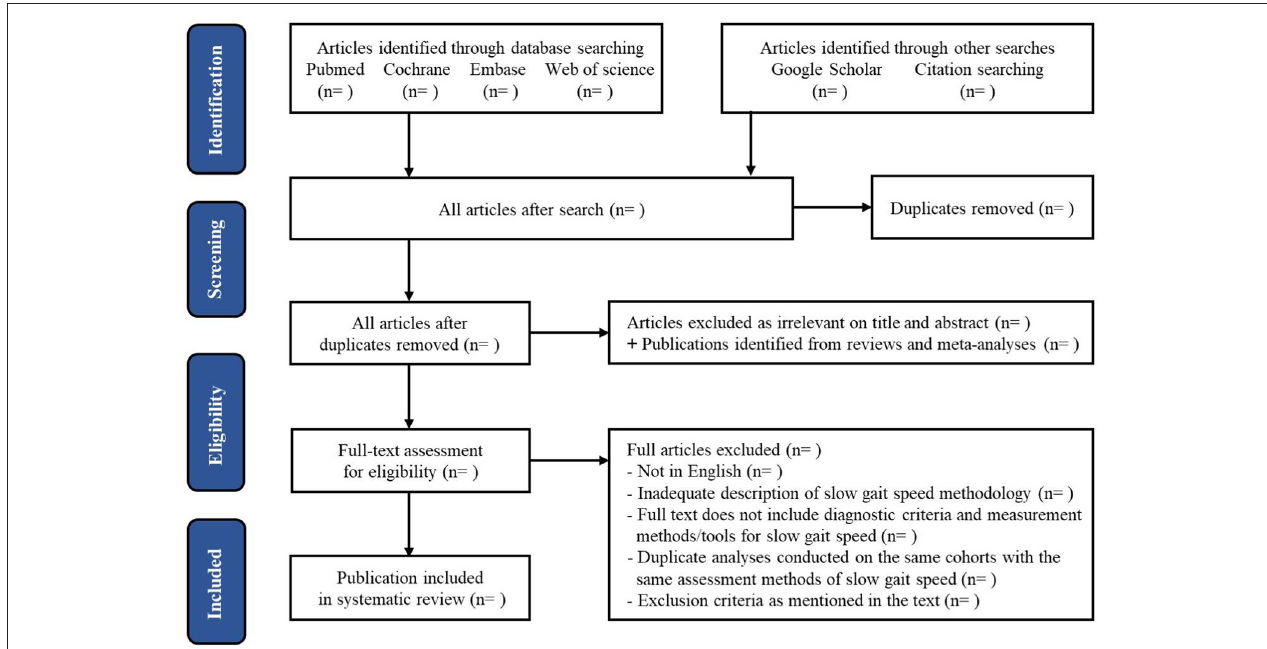
FIGURE 1 | Systematic review